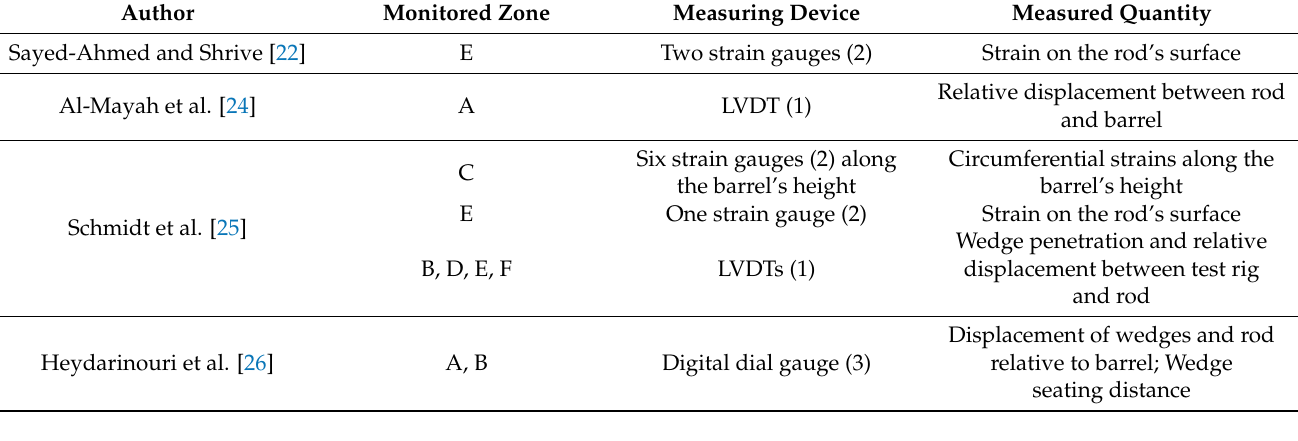
Table 9. Literature experimental tests on split wedge anchorages—monitored zone, adopted measuring device, and measured quantity.